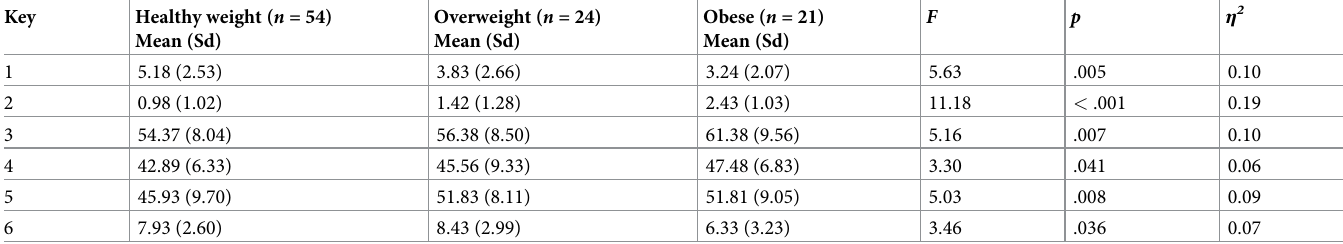
Table 4. Diabetes group one-way ANOVA for BMI